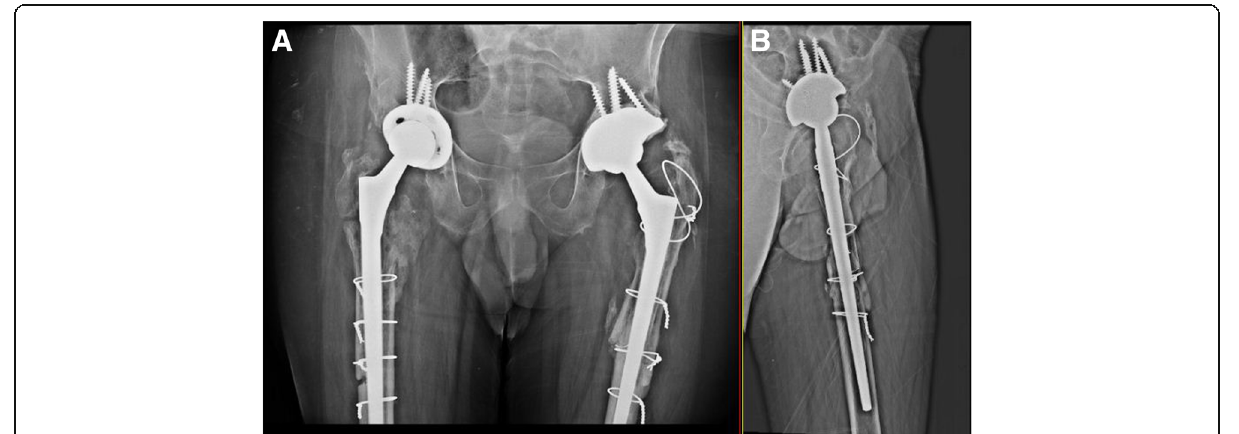
Fig. 4 Radiographs at 3 years follow up. a Anteroposterior view. b Lateral